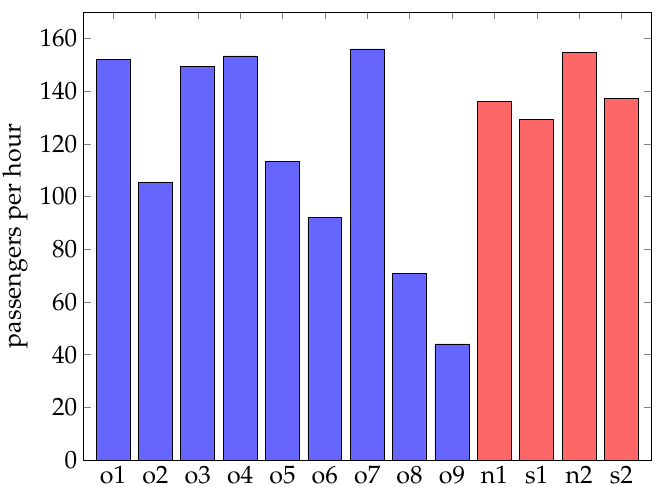
Figure 14. The maximum throughput (normalized to passengers per hour) for the thirteen different security checkpoint lanes.